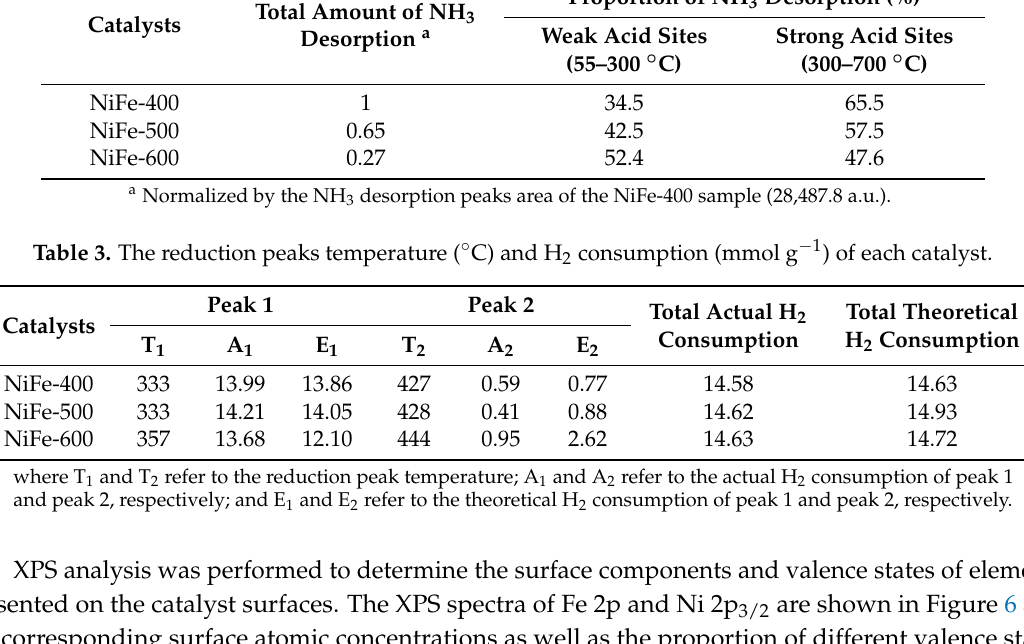
Table 2. Amount and proportion of NH 3 desorption of the serial catalysts.